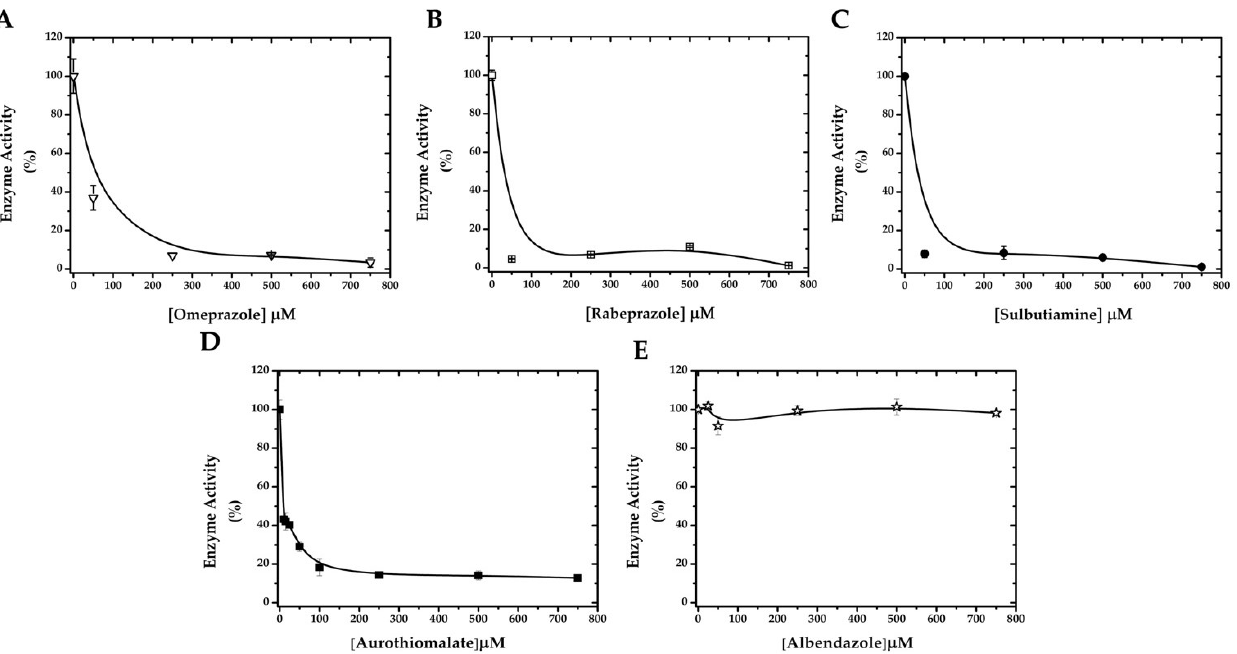
Figure 4. Effect of repurposing drugs approved for use in humans on the enzyme activity of GlADI. The enzyme was incubated with increasing concentrations of omeprazole ( A ), rabeprazole ( B ), sulbutiamine ( C ), aurothiomalate ( D ), and albendazole ( E ).